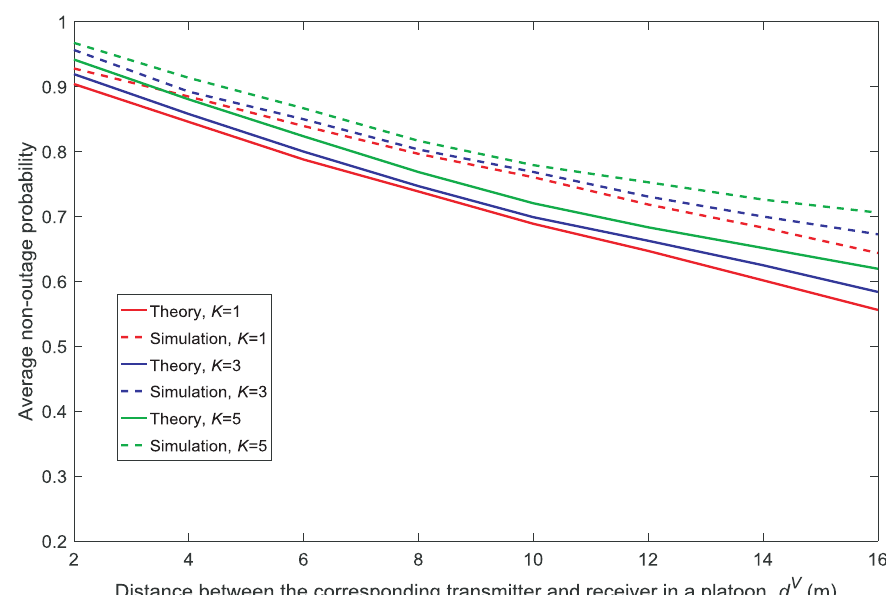
Figure 5. Average non-outage probability for different distances between the corresponding transmitter and receiver in a platoon d V ( λ = 1/1000, V = 10, N = 5 )